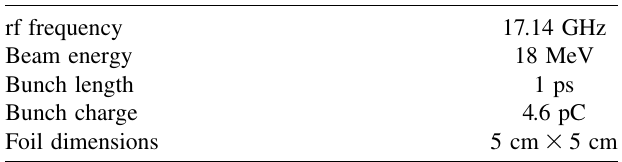
TABLE I. Operating